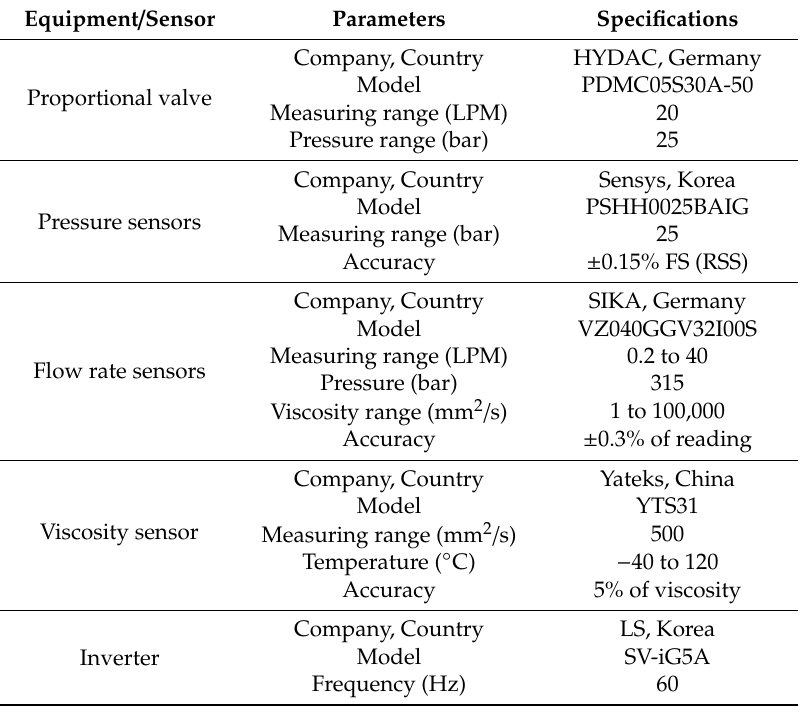
Table 2. The specifications of the equipment and sensors used in this study.